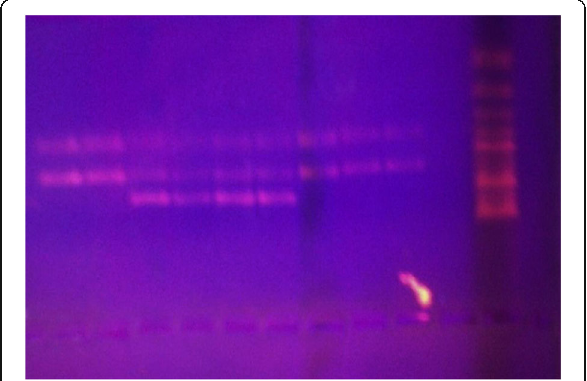
Fig. 1 Gel electrophoriesis for the digested PCR products shows the GG genotype as 2 bands and the GT genotype as 3